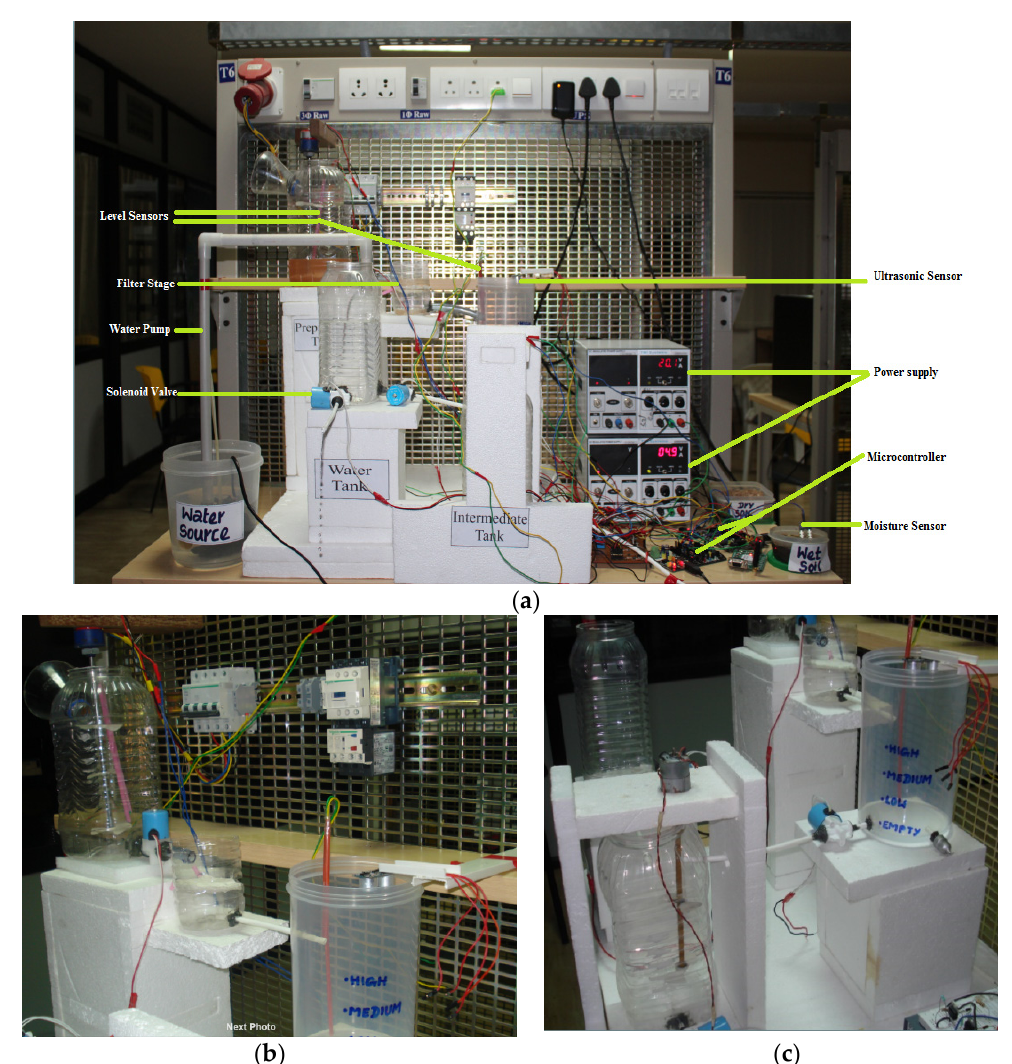
Figure 4. ( a ) Hardware setup of the proposed pilot scale model, ( b ) implementation of the preparation module, and ( c ) implementation of the irrigation module.